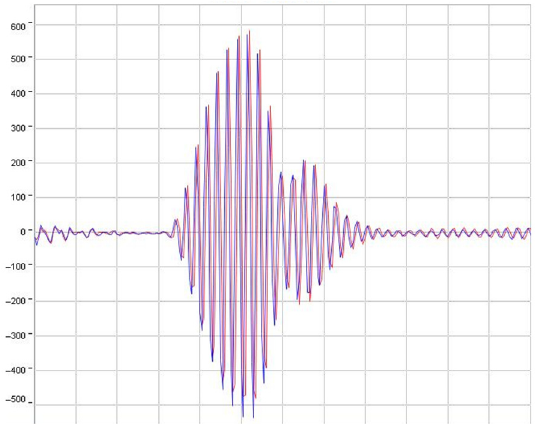
Figure 3. Received signal waveforms.